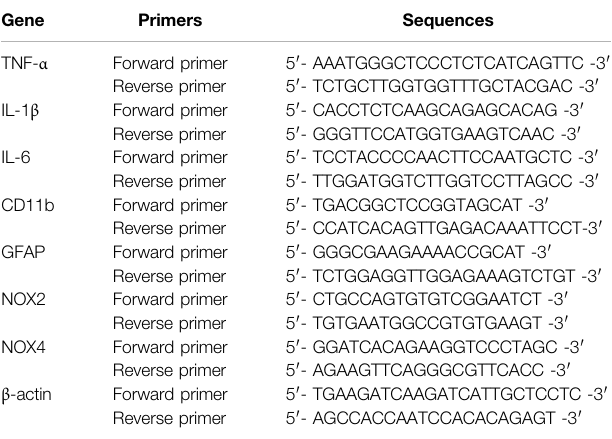
TABLE 1 | Sequences for